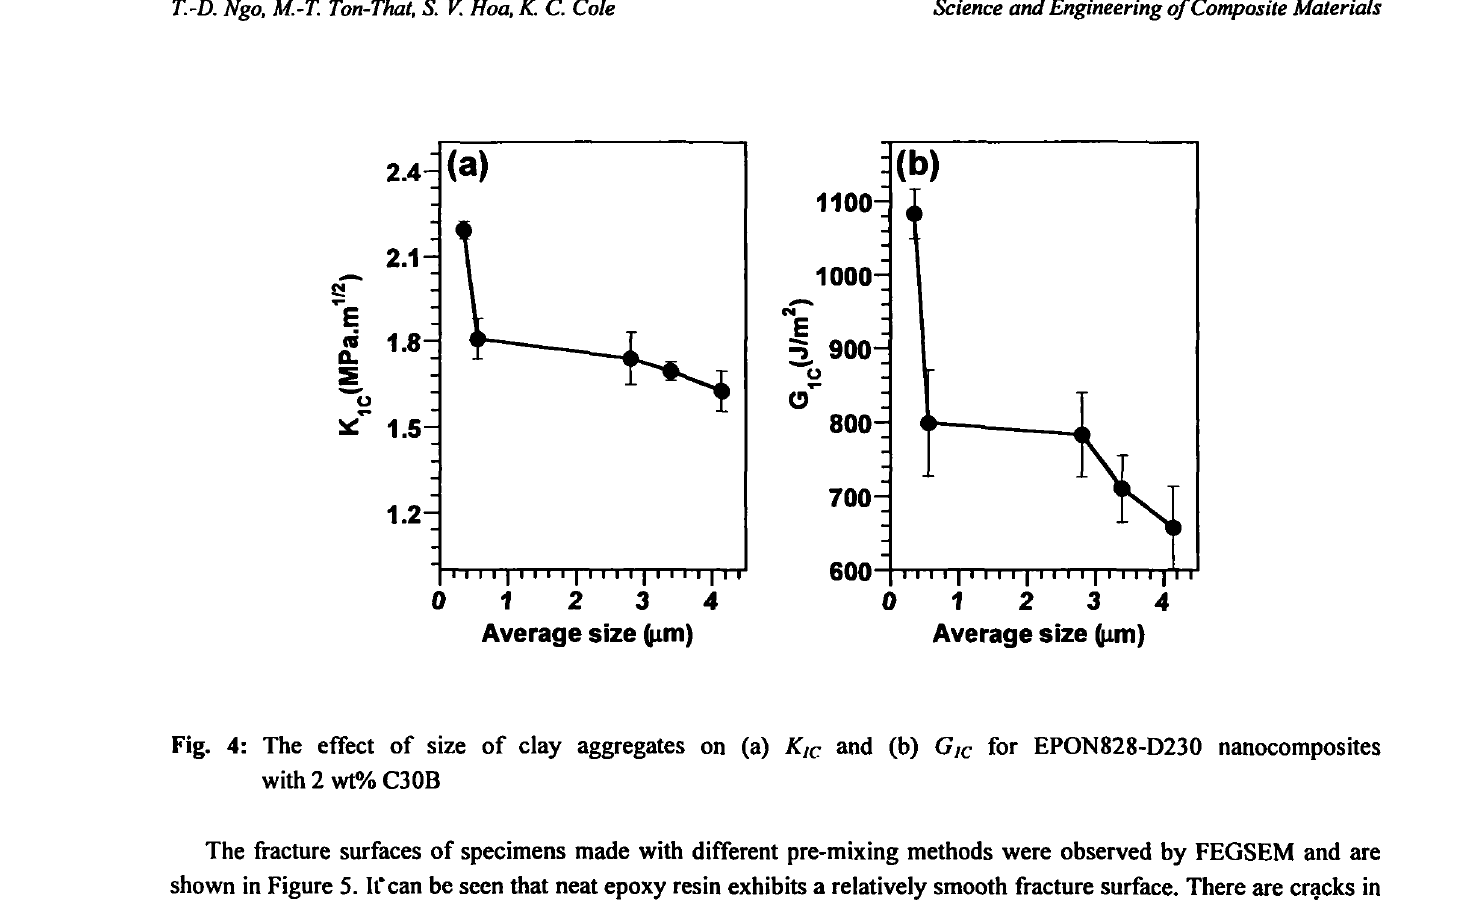
Fig. 4: The effect of size of clay aggregates on (a) K, with 2 wt%